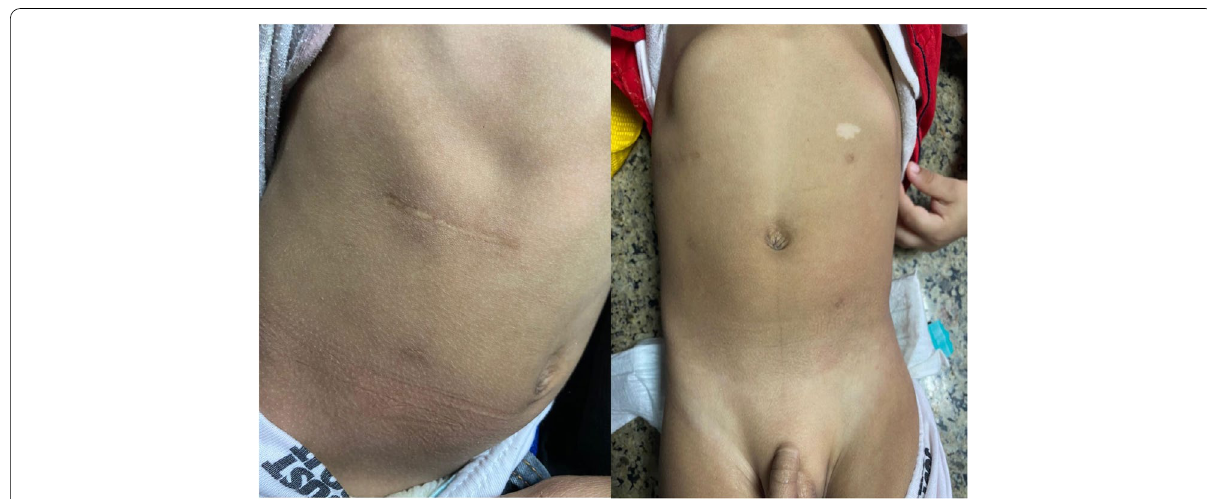
Fig. 6 Cosmetic outcome in patient with bilateral pyeloplasty. The right side was operated by open technique and the left side by laparoscopic technique. Postoperative appearance after 12 months showing wounds less than 5 mm in the left